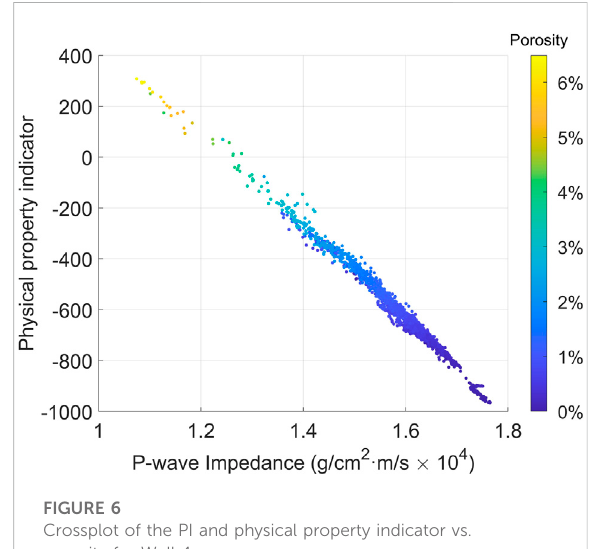
Crossplots of P-wave impedance, S-wave impedance, and porosity.